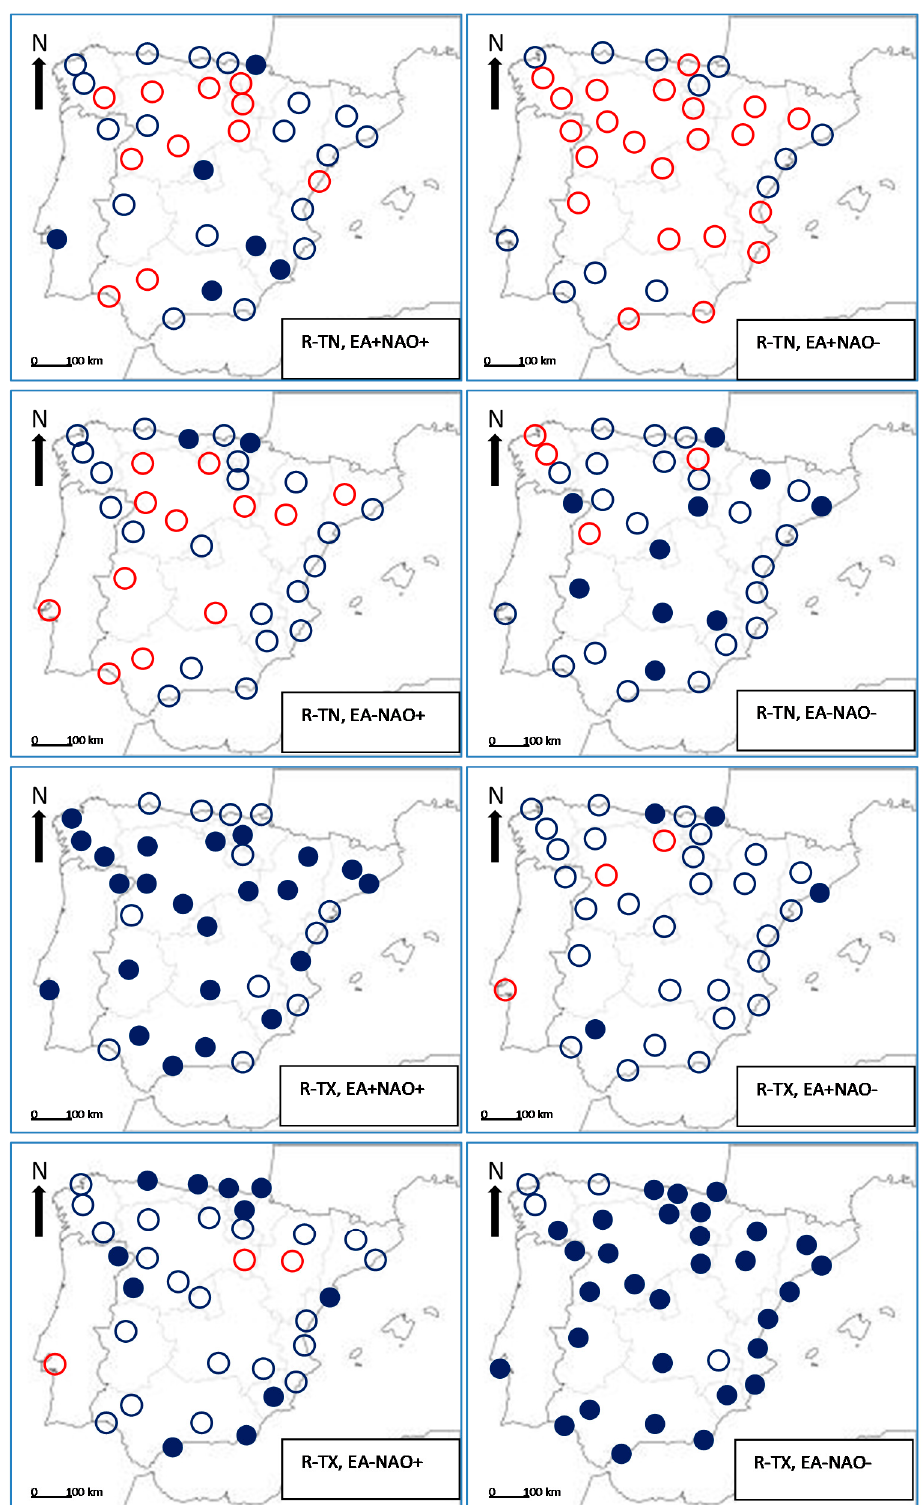
Figure 9. Correlation coefficients between TN, TX and R under the four composites EA+NAO+, EA+NAO-, EA-NAO+ and EA+NAO+ for spring. Red: positive; blue: negative; full (empty): significant (non-significant) at the 95% confidence level.